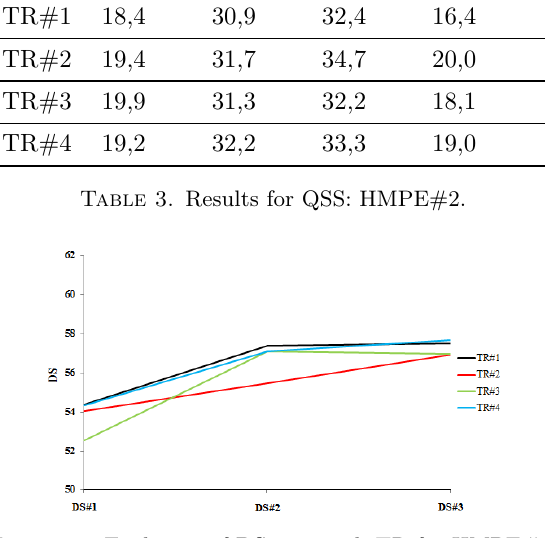
Figure 6. Evolution of DS over each TR for HMPE#2. up to calculation #3 (QSS#3 and DS#3). In other words, the more you cycle these materials, the more stiff they get, until they reach what appears to be a limiting stiffness.